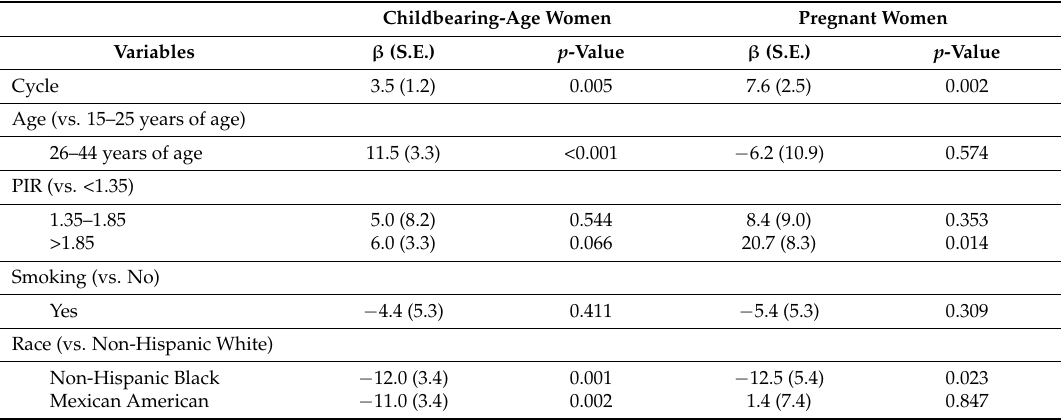
Table 7. Change of EPA and DHA intakes (from foods and dietary supplements combined) over 14-year span 1